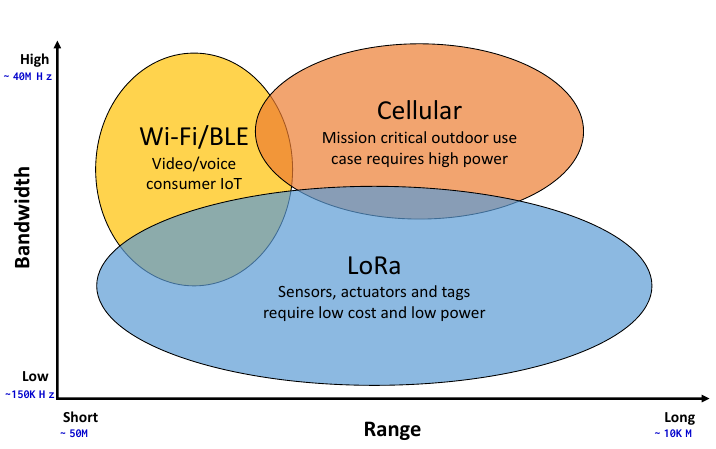
Figure 2. LoRa filling the technology